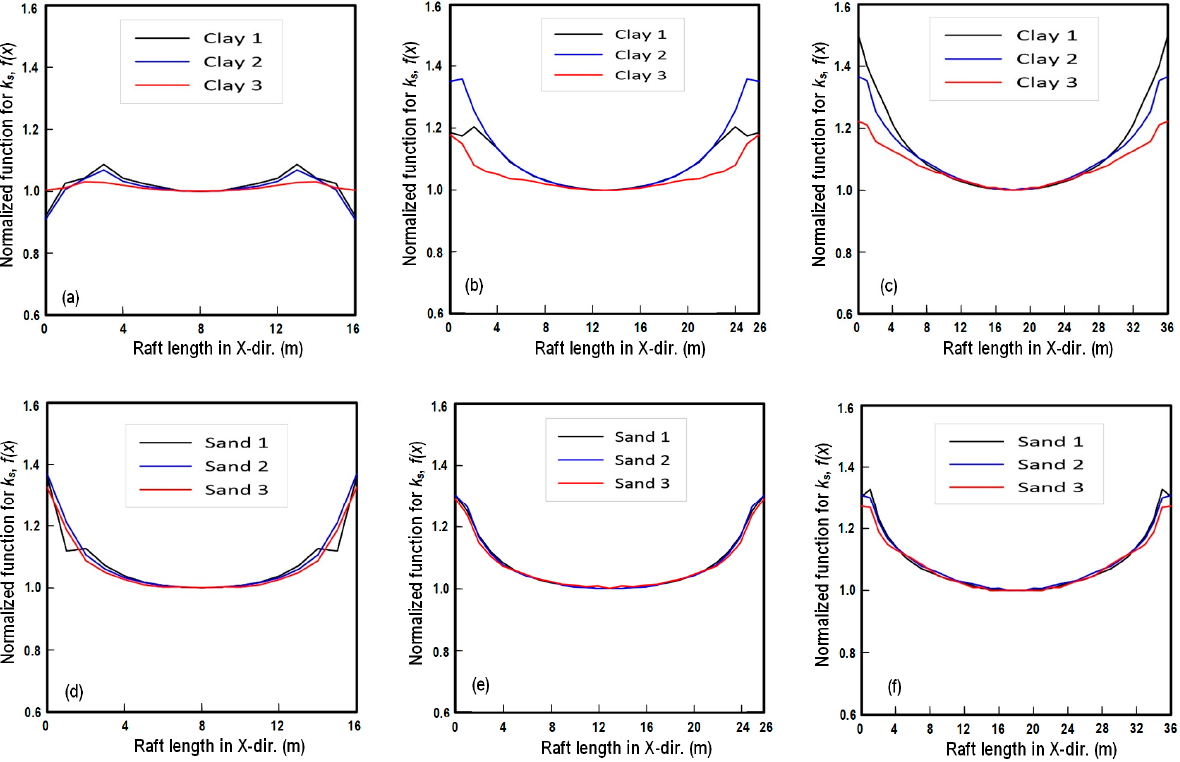
Figure 8. Normalized function for coefficients of subgrade reactions, k s of raft foundations with different dimensions: ( a ) 16 m, ( b ) 26 m, ( c ) 36 m in clays; ( d ) 16 m, ( e ) 26 m, ( f ) 36 m in sands.